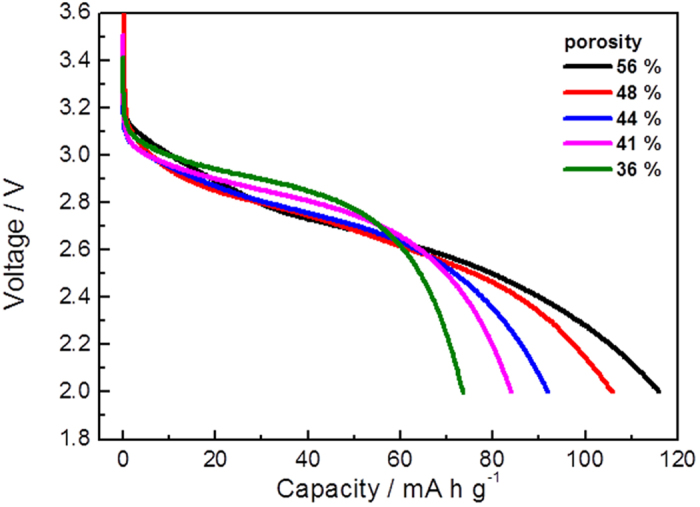
Discharge curves of LiFePO4 composite electrodes at 10 C rate at various porosities.